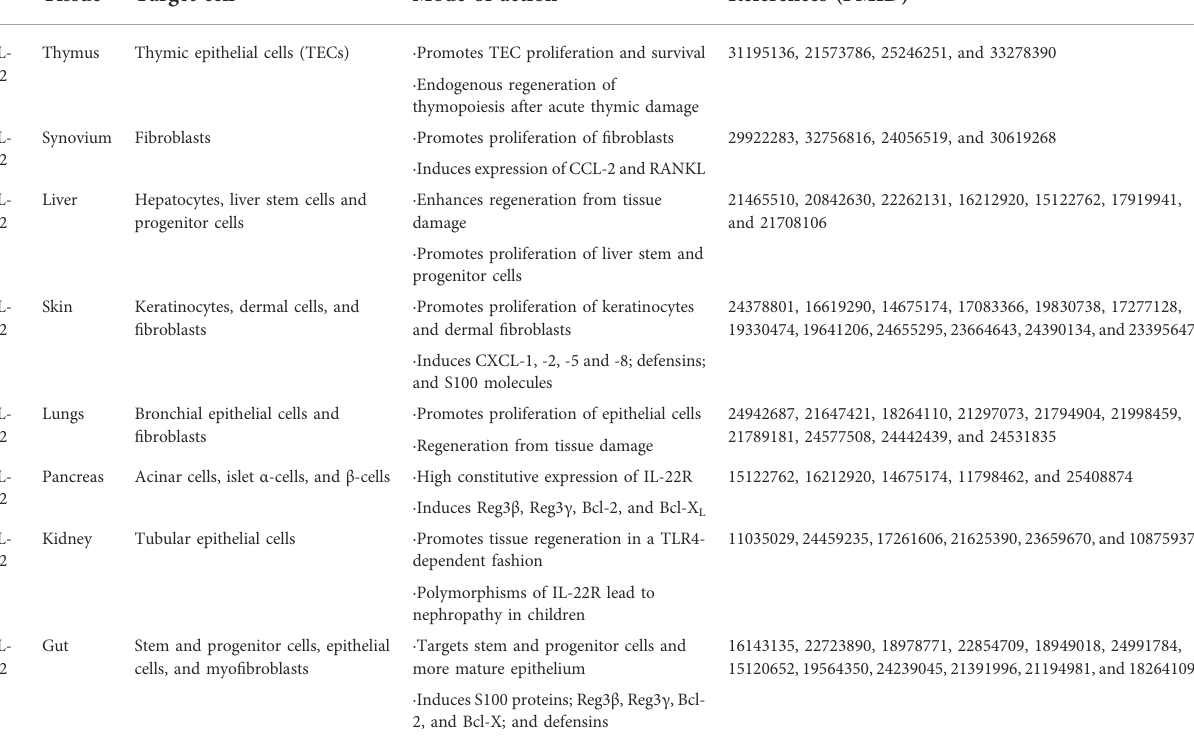
TABLE 1 Target tissues and physiological effects of